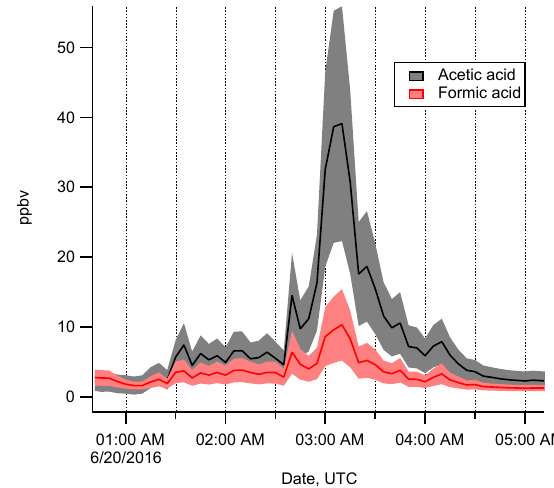
Figure 4. Expanded view of the time series on 20 June 2016, dur- ing which a very large excursion in FA and AA mixing ratios was observed. Note the factor of 10 difference in the y axis scale. This large excursion to high values took place during a light precipitation event under stagnant ( ∼ 1 . 5ms − 1 ), cool ( ∼ 4 ◦ C), and low-light (overcast) conditions. Shaded areas indicate calibration uncertainty (range between highest and lowest estimate, Sect.